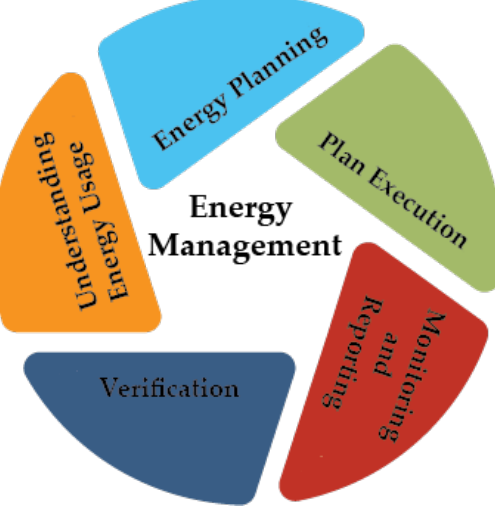
Figure 2. Simple energy management process.